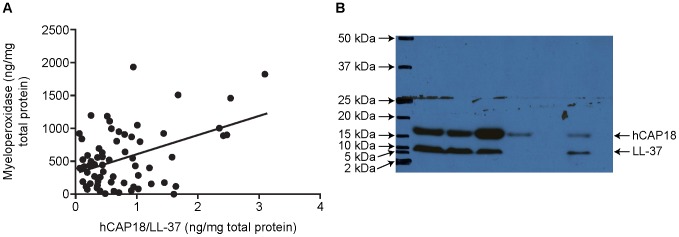
Cervical hCAP18/LL-37 expression.(A) Correlation between cervicovaginal hCAP18/LL-37 and Myeloperoxidase (r = 0.1; n = 77; p = 0.3). (B) Representative western blot of hCAP18/LL-37 expression in cervicovaginal secretions. The 18 kDa hCAP18 and the 5–10 kDa cleaved peptide LL-37 were detected in cervicovaginal secretions.